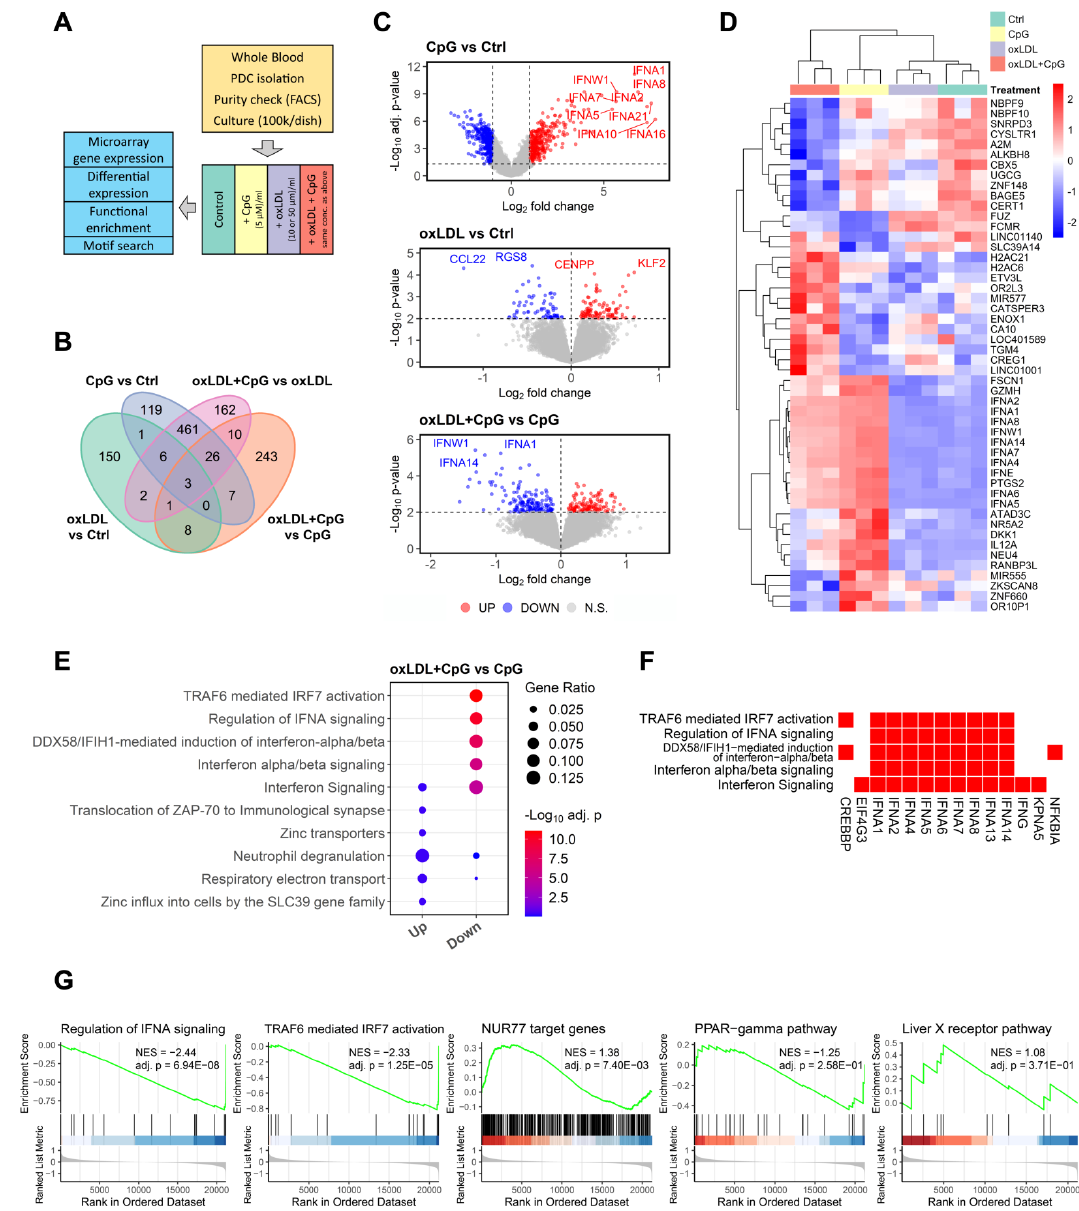
Figure 5. Transcriptional expression profiling reveals that oxLDL inhibits CpG-A induced activation by interfering with TRAF6 signaling and type-I interferon responses. ( A ) Flow scheme of the experimental setup of the profiling study. ( B ) DEGs of the four comparisons and their intersection. ( C ) Volcano plot of the gene expression data of CpG-A activated pDCs versus control (upper panel), oxLDL activated pDCs vs. control (middle panel), and CpG-A activated pDCs with/without oxLDL (lower panel). ( D ) Heatmap of gene expression of the 50 most significant oxLDL + CpG vs. CpG DEGs for the four study arms. ( E ) Gene set overrepresentation analysis of oxLDL + CpG vs. CpG DEGs. For either up-regulated or down-regulated DEGs, the five most significant reactome pathways are selectively shown. ( F ) Down-regulated oxLDL + CpG vs. CpG DEGs that are involved in the five Reactome pathways in ( E ). ( G ) Gene set enrichment analysis of oxLDL-induced overall gene expression upon CpG treatment (oxLDL + CpG vs. CpG, all genes). The two most significant Reactome pathways (first two), the 371 NUR77 targets retrieved from Harmonizome database [28], as well as two pathways from WikiPathways database [29] (last two) are selectively shown. For the comparison of oxLDL + CpG vs. CpG in ( E – G ), up-regulation, higher expression in oxLDL + CpG; down-regulation, higher expression in